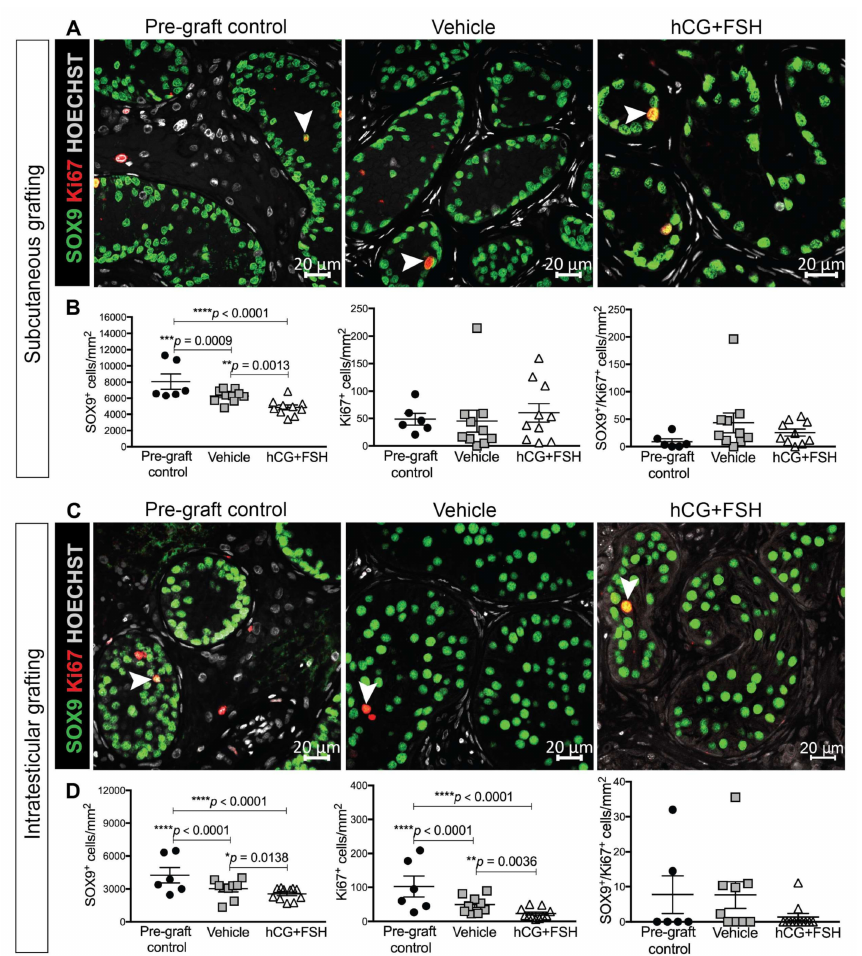
Figure 5. Proliferation of Sertoli cells in prepubertal human testis grafts. ( A ) Immunofluorescence for Sertoli cells (SOX9 + ) and proliferating cells (Ki67 + ) in subcutaneous xenografts. Pre-graft control (14 year old). ( B ) Quantification of proliferating Sertoli cells per square millimetre. ( C ) Immunofluorescence for Sertoli cells (SOX9 + ) and proliferating cells (Ki67 + ) in intratesticular xenografts. Pre-graft control (14 year old). ( D ) Quantification of proliferating Sertoli cells per square millimetre. Statistical significance was determined using two-way ANOVA. Data are presented as mean ± SEM ( n = 3 prepubertal testis samples per transplantation site). Arrowheads point to SOX9 + / Ki67 + Sertoli